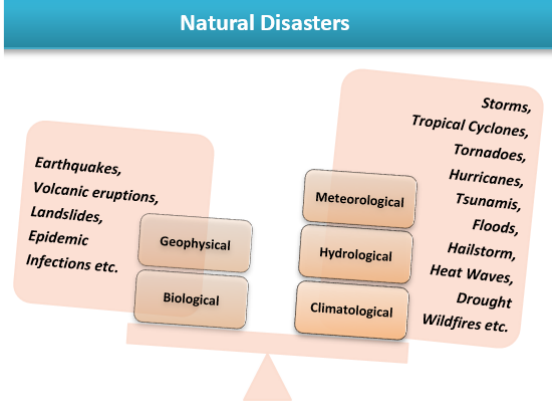
Figure 1. Types of natural disasters and their effect